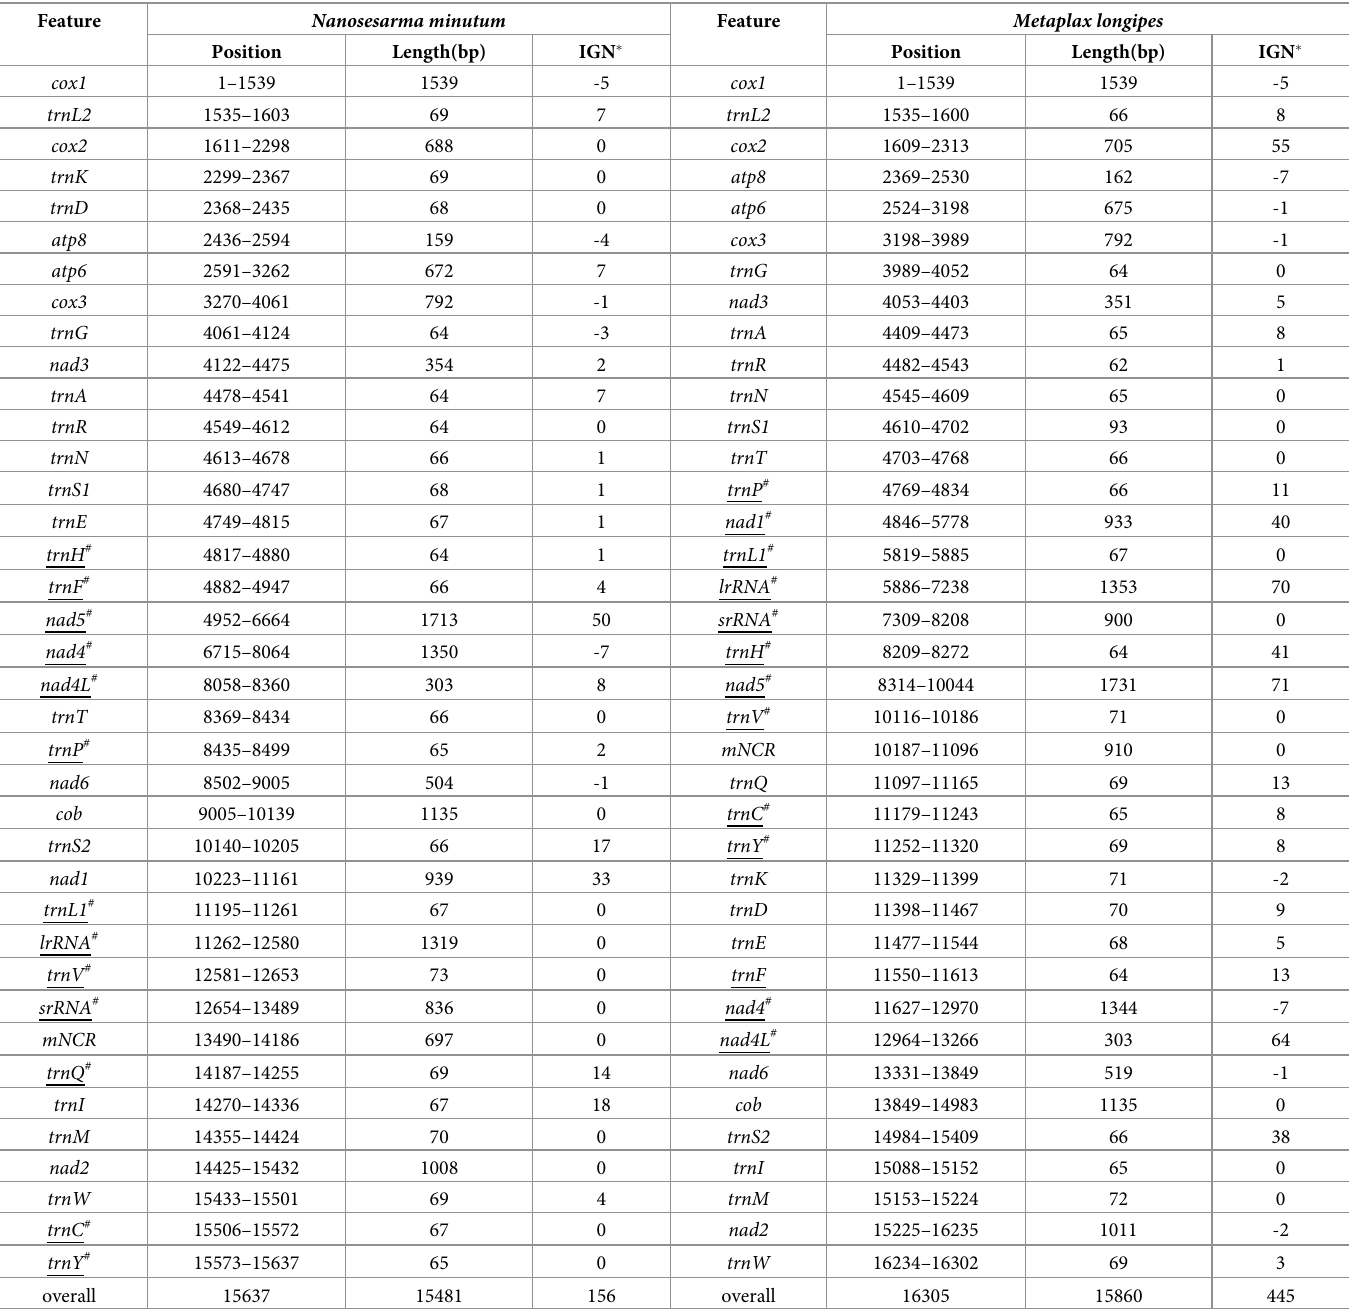
Table 1. Mitogenomic features of Nanosesarma minutum and Metaplax longipes